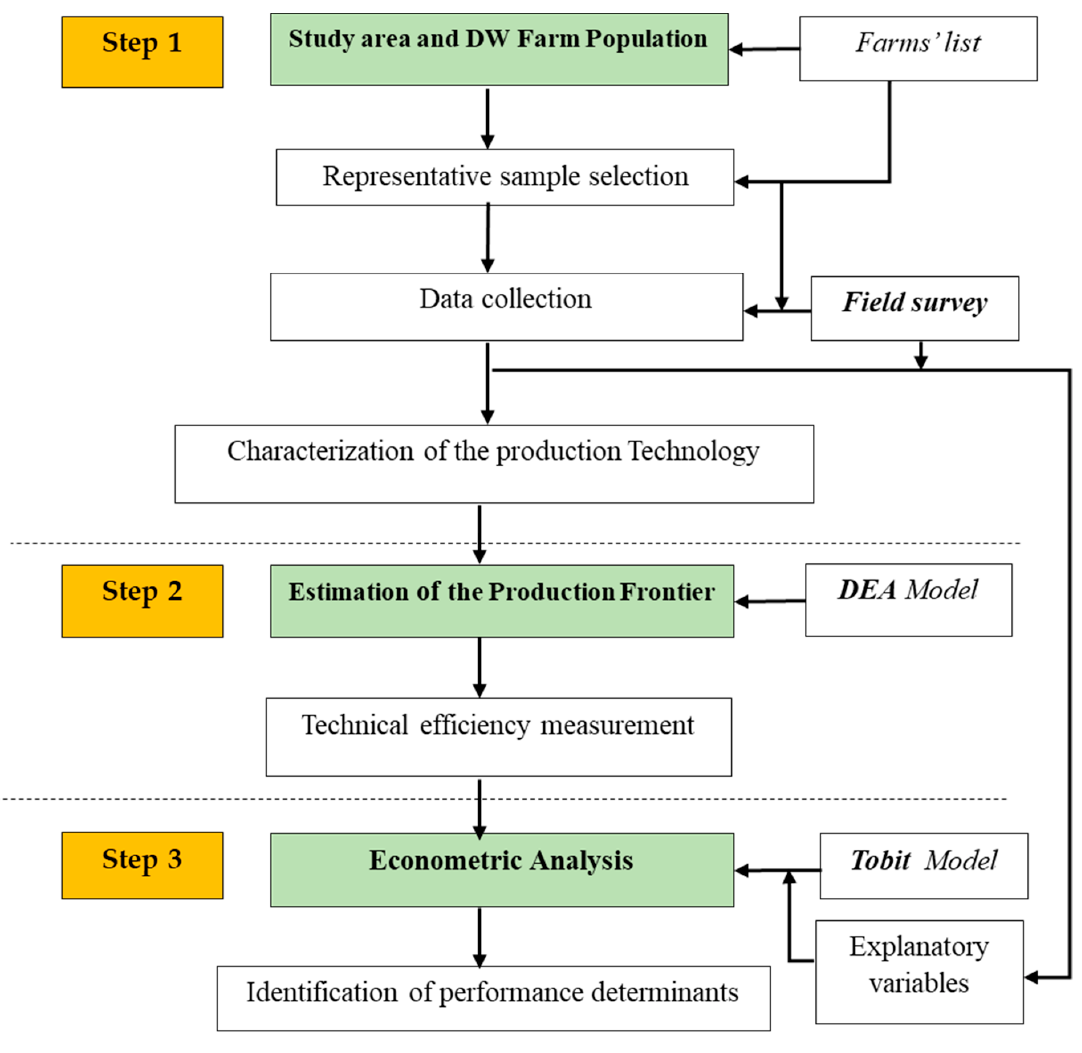
Figure 1. Conceptual framework of the analysis .